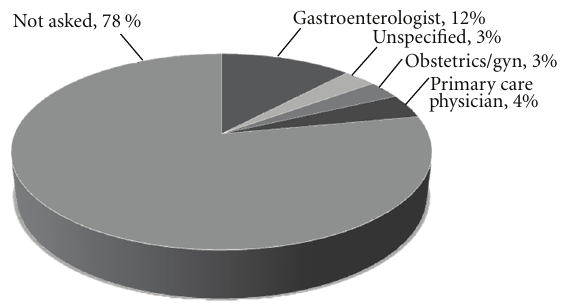
Figure 1: Percent of patients who had previously discussed with a physician, according to type of physician.